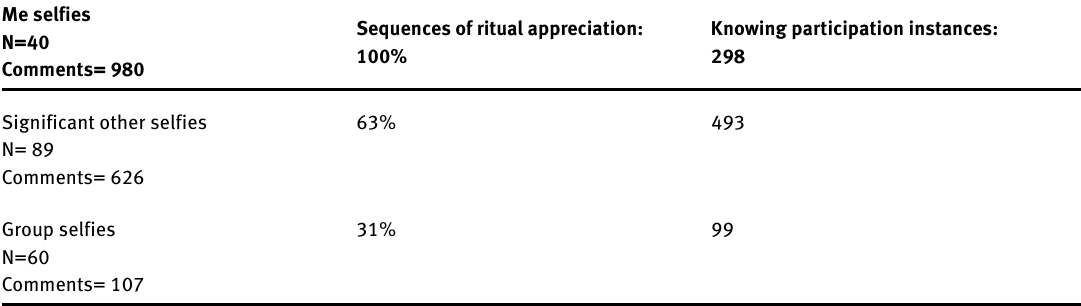
Sequences of ritual